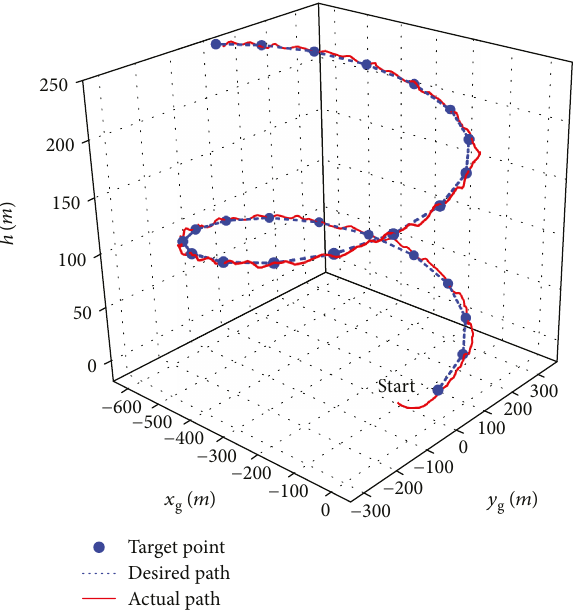
Figure 11: The airship 3D path-following